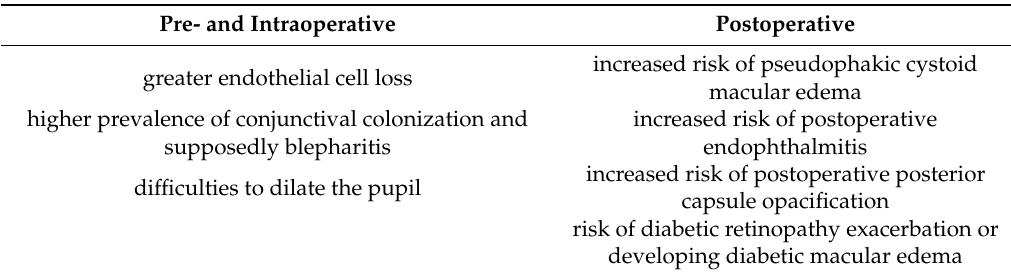
Table 1. Problems associated with cataract surgery in a diabetic